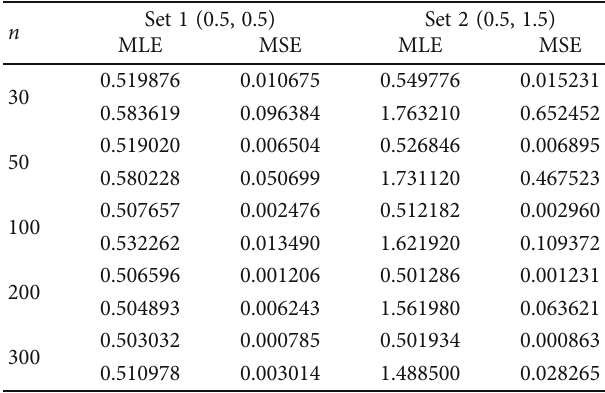
Table 9: Some descriptive analysis of data set 1.